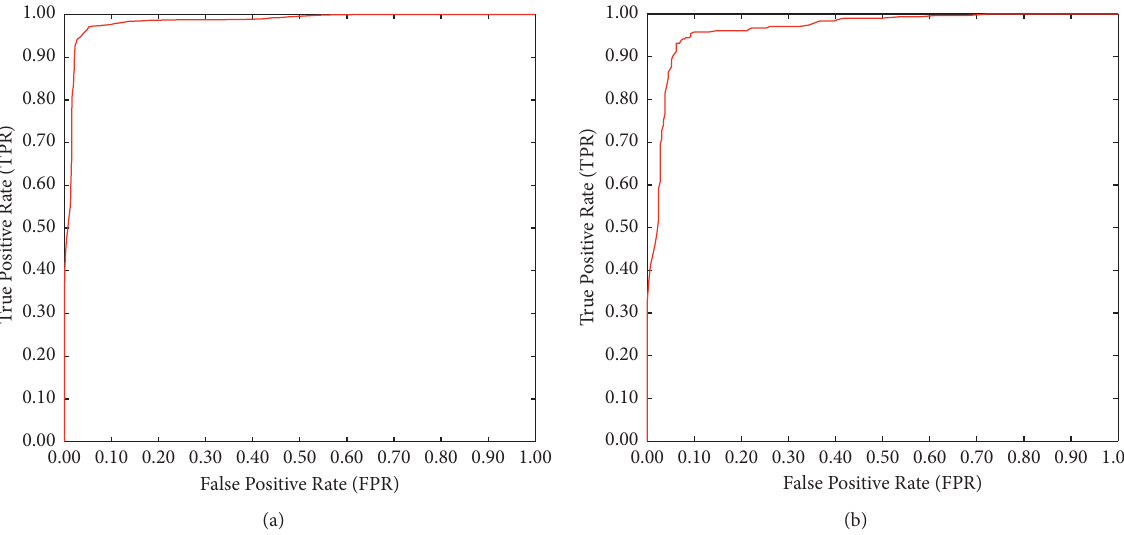
Figure 11: ROCs of JSO-SVC: (a) training phase and (b) testing phase.